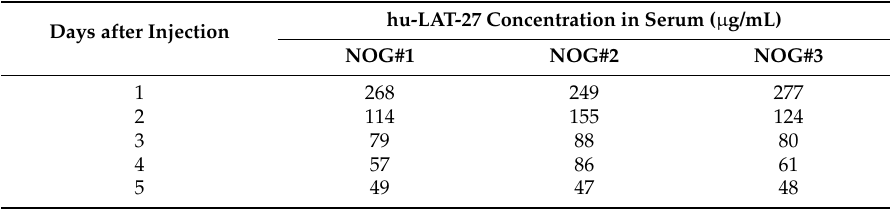
Table2. Retention of humanized LAT-27 in NOG mice. Each of three NOG mice was infused i.v. with 1 mg/head hu-LAT-27, and the LAT-27 concentrations in their sera were measured daily by ELISA using gp46 peptide (180–204) as antigen and secondary anti-human IgG-HRP, in which purified hu-LAT-27 was used to draw a standard curve.